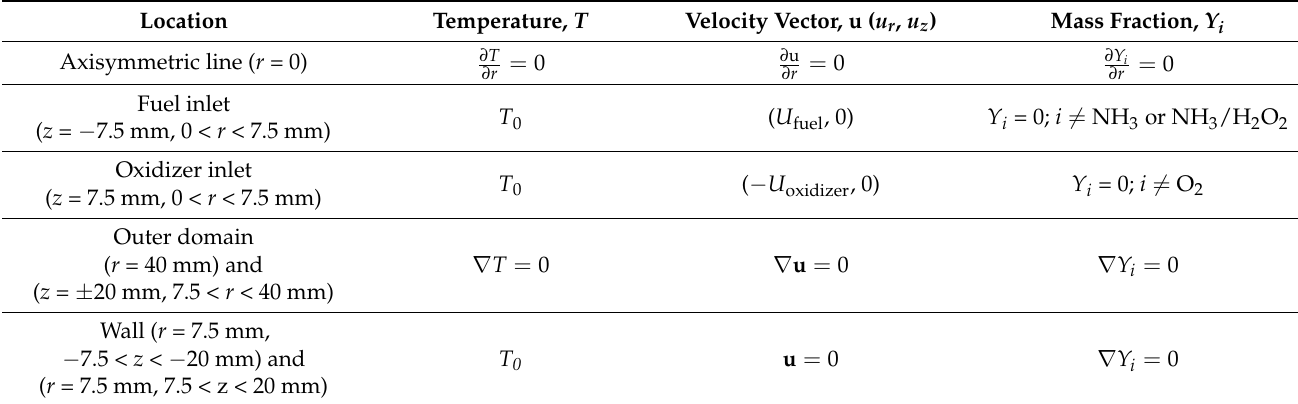
Table 1. Boundary conditions (T 0 = 300